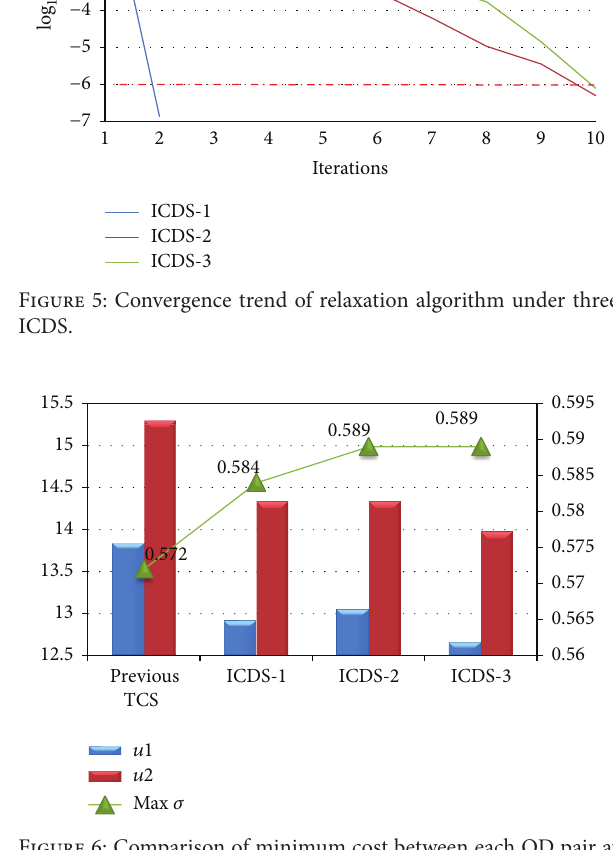
Figure 6: Comparison of minimum cost between each OD pair at maximum 𝜎